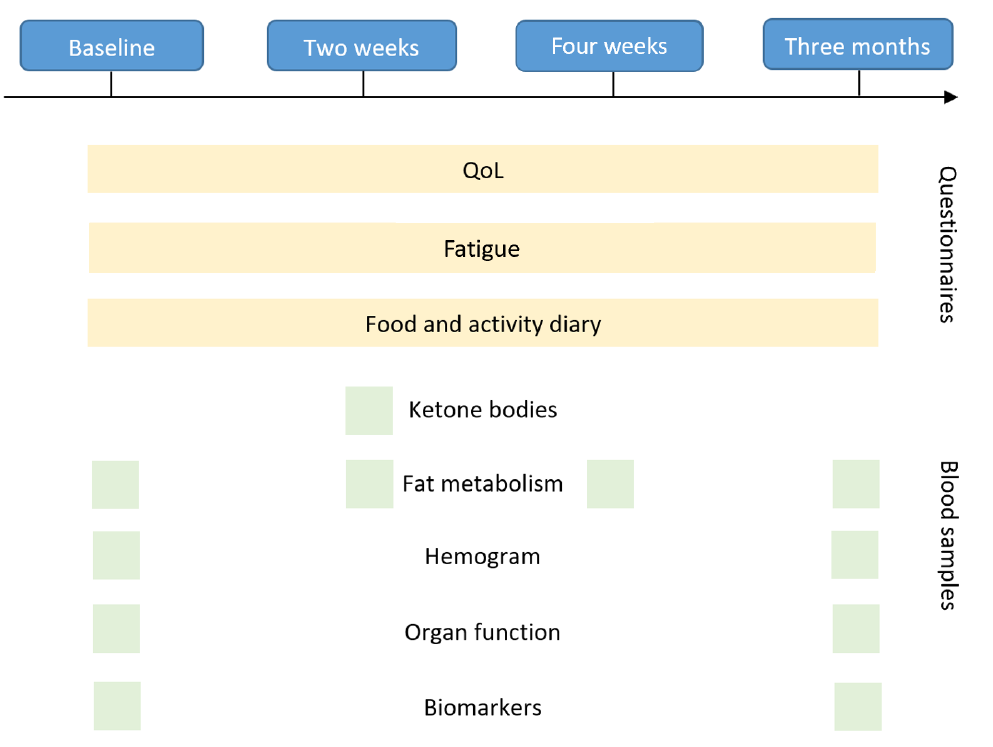
Figure 1. Outcome measures assessed during each study visit .